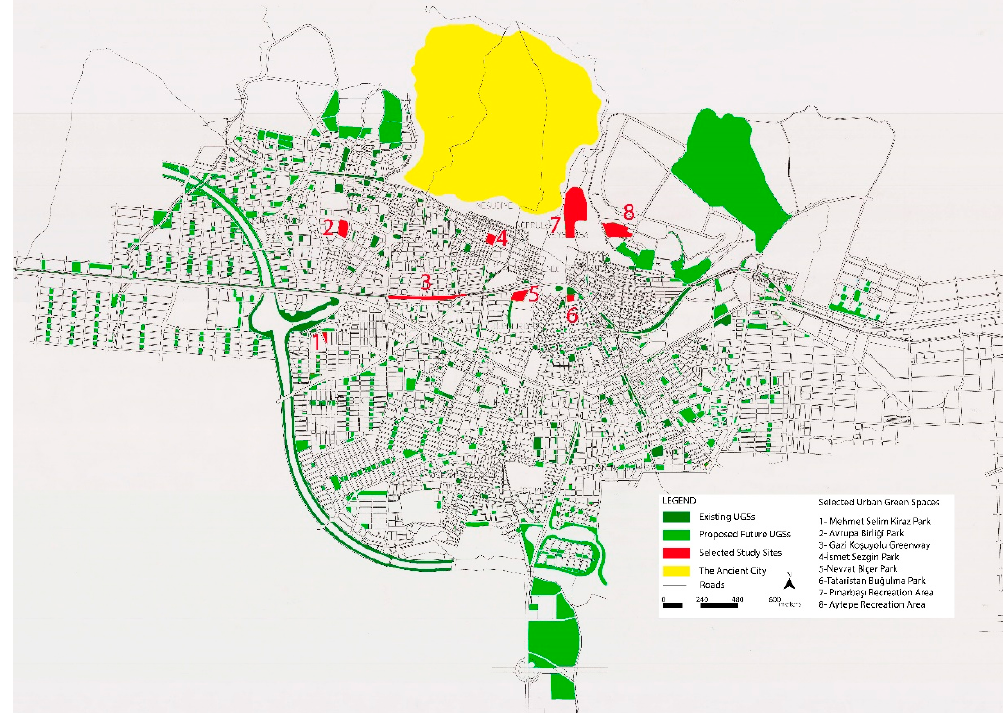
Figure 1. Selected study sites within the city limit [59].